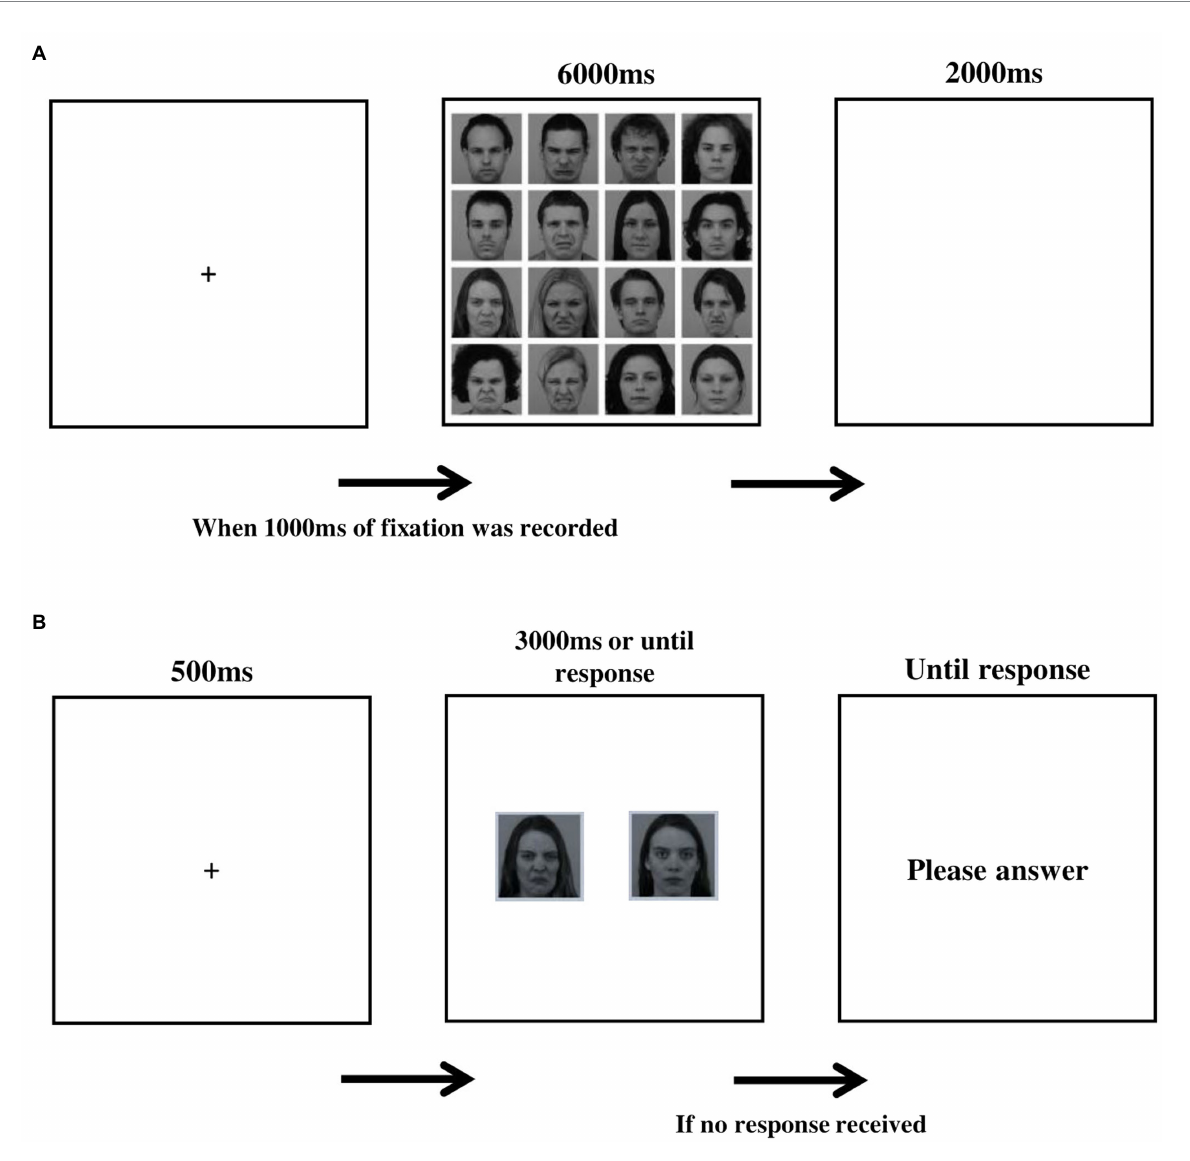
FIGURE 1 (A) Schematic illustration of a trial in the encoding stage. (B) Schematic illustration of a trial in the recognition